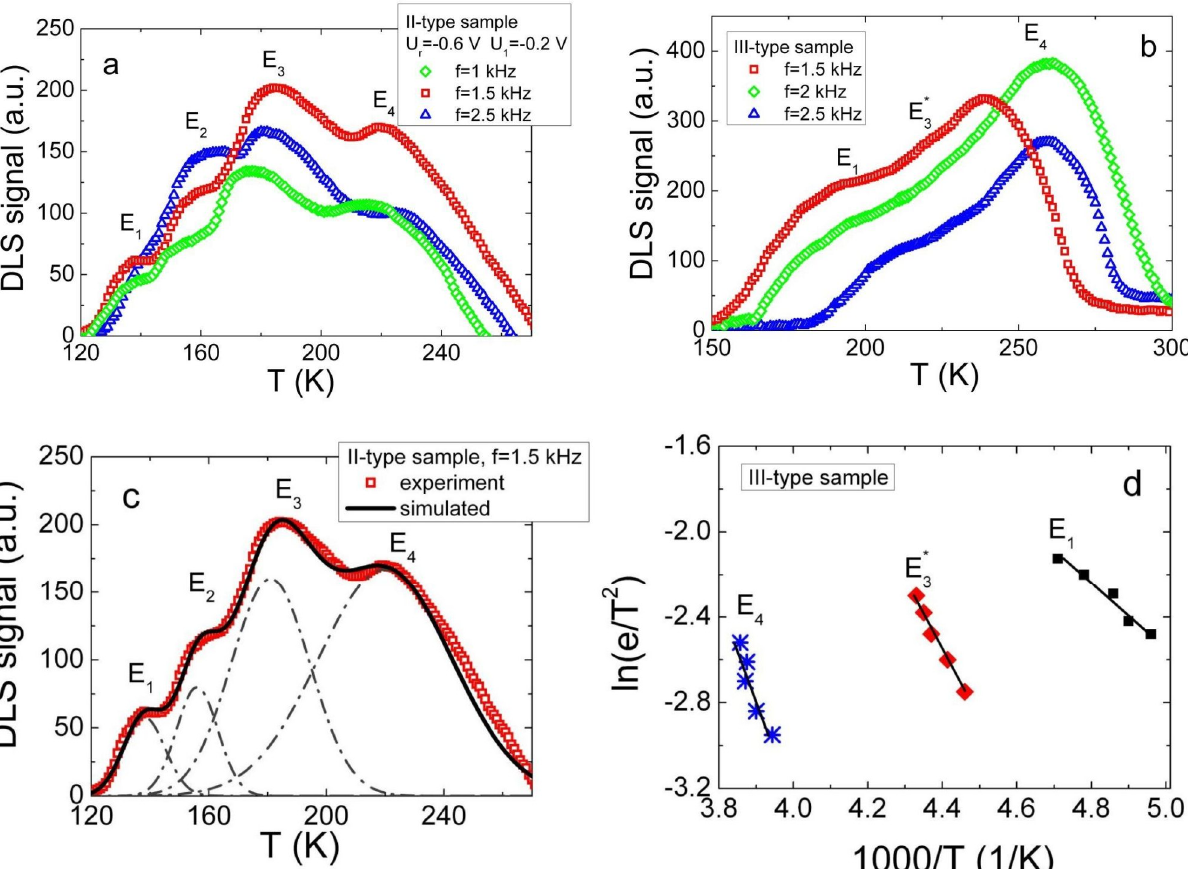
Figure 2. The capacitance deep level transient spectroscopy technique together with white LED light additional illumination (C-DLTS-WL) spectra obtained on samples of the S-CdS junction samples, as measured at 0.6 V reverse II-type ( a ) and III-type ( b ) of Cu 2 bias voltage using temperature scan regime for the lock-in frequencies range from 400 to 2500 Hz; ( c ) The simulated spectrum of sample of type-II; ( d ) The Arrhenius plots for III-type